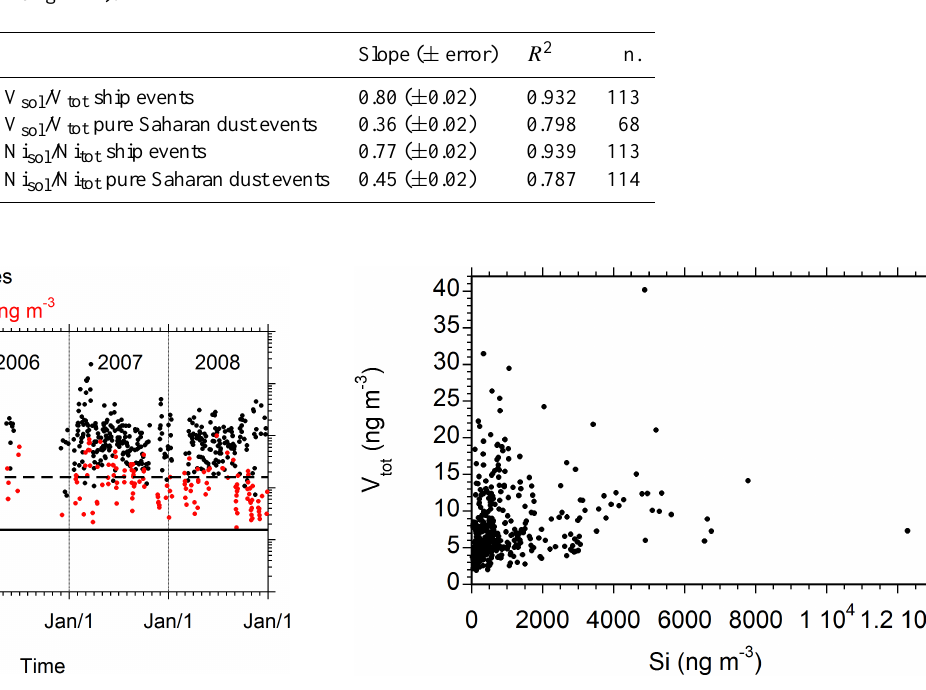
Table 1. Correlation parameters between V and Ni soluble and total fractions for ship aerosol cases (V sol > 6ngm − 3 ) and for Saharan dust cases (Si > 925ngm − 3 and V sol < 6ngm − 3 ).